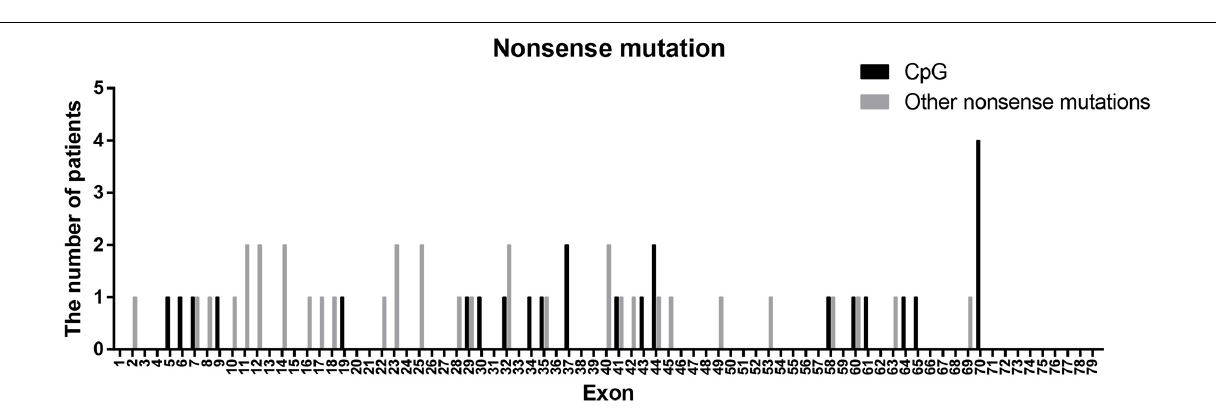
FIGURE 4 | Positional distribution of nonsense mutations located in CpG dinucleotides and other